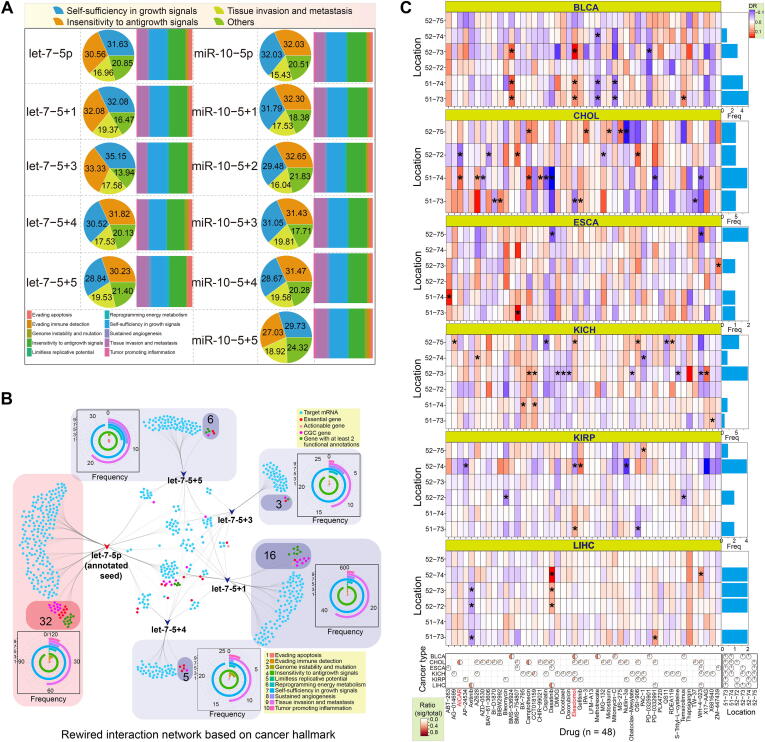
Rewired regulatory networks of novel seeds compared with annotated seeds. (A) Distribution of target genes with functional annotations between novel and annotated seeds, including actionable, CGC, core essential, oncogene, and TSG genes. (B) Rewired isomiR-mRNA interaction network based on target genes associated with cancer hallmarks among seeds from the let-7-5p locus. These genes are further classified according to their functional annotations, including actionable, CGC, core essential, oncogene, and TSG genes. Frequencies of genes associated with cancer hallmarks are also presented for specific targets of each involved seed. (C) Drug responses for six isomiRs (two seeds) of the let-7a-5p locus. A total of 48 drugs are shown, and a significant difference in drug response is observed for each in at least one cancer type. Data for six cancer types are presented (at least five points with significant difference), and other data can be found in Supplementary Fig. S5. Asterisks (*) indicate drugs for which a significant difference was observed between the abnormal expression and normal expression groups (DR > 0.1 or DR <  − 0.1 and p < 0.05). Among the six isomiRs, only four were detected in CHOL. “DR” indicates a difference in the values of the shifted seed group and the annotated seed group. “Freq” indicates frequency. “Sig/total” indicates the ratio of the number of significant results and the total number of isomiRs (pie distribution, left) or the total number of drugs (pie distribution, right). The location annotation provides a detailed locus for each isomiR. For example, 51–73 indicates the location hg38:chr22:46112751–46112773:+.